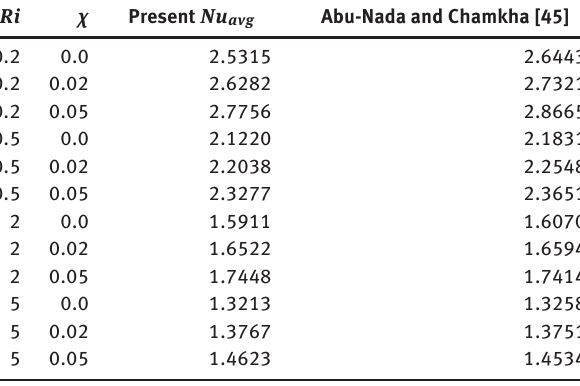
Table 3: Comparison of the average Nusselt number between the present numerical results and Abu-Nada and Chamkha